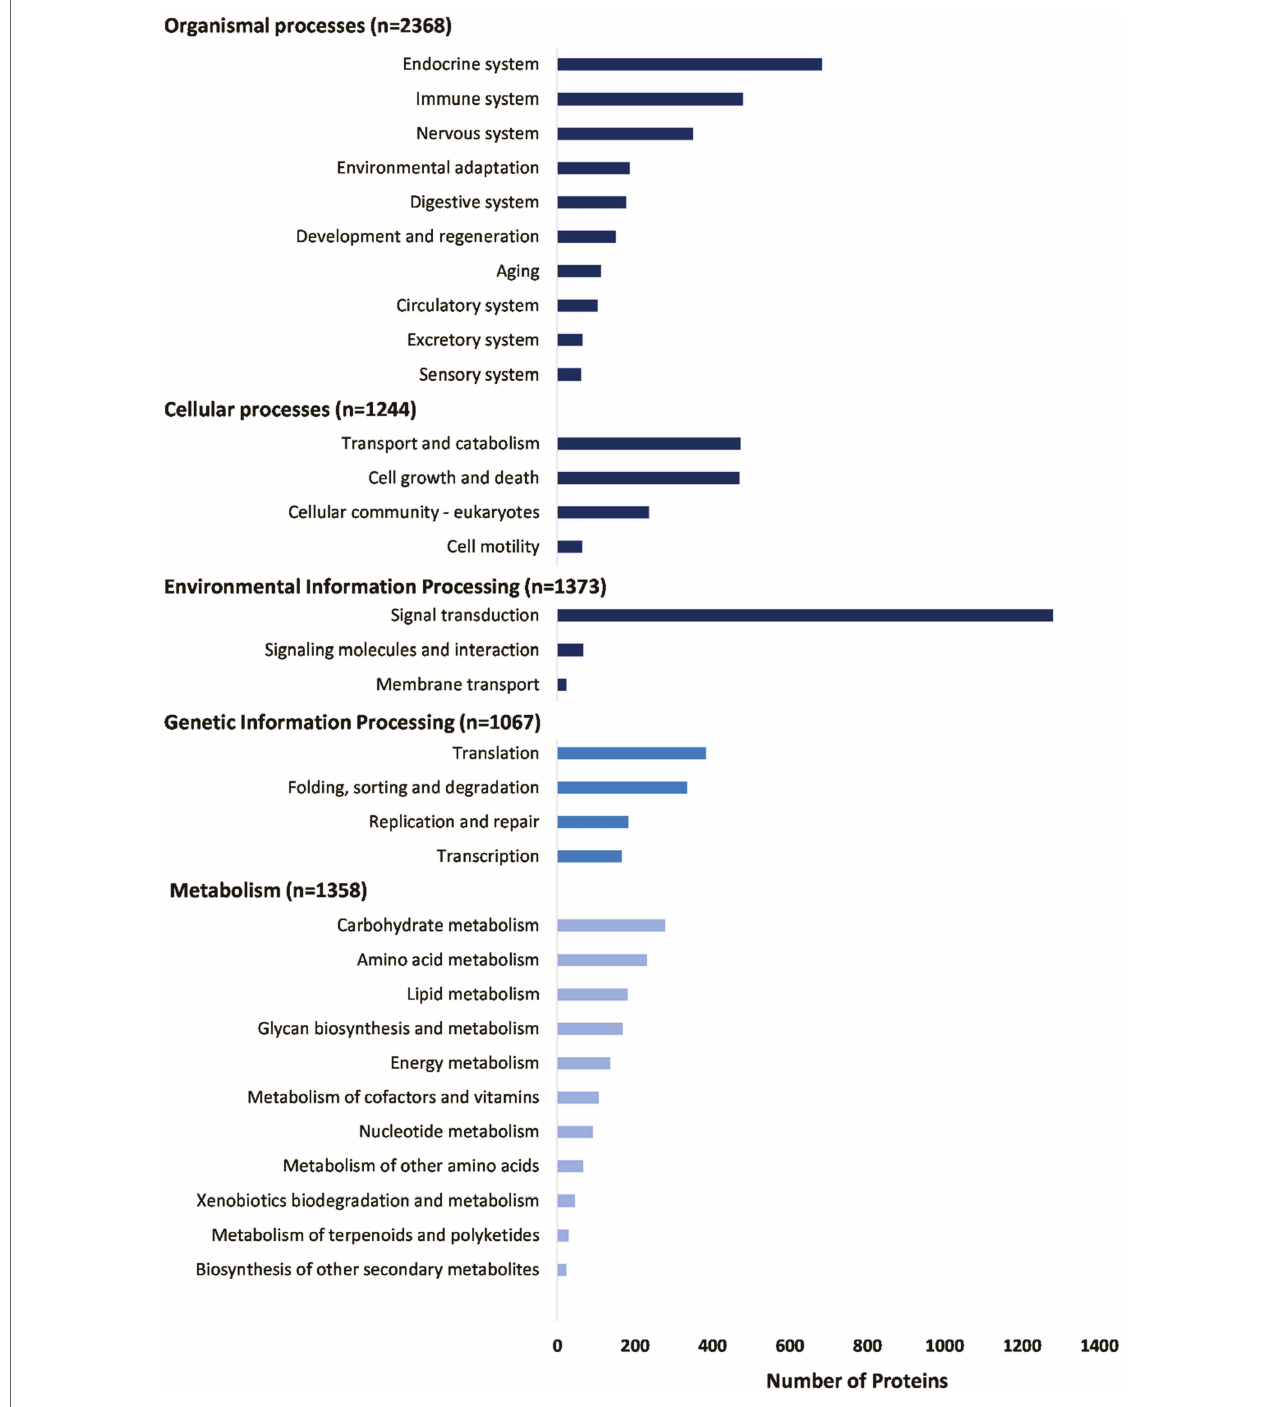
FIGURE 5 | Summary of housekeeping proteins as annotated by the GhostKOALA search of the KEGG